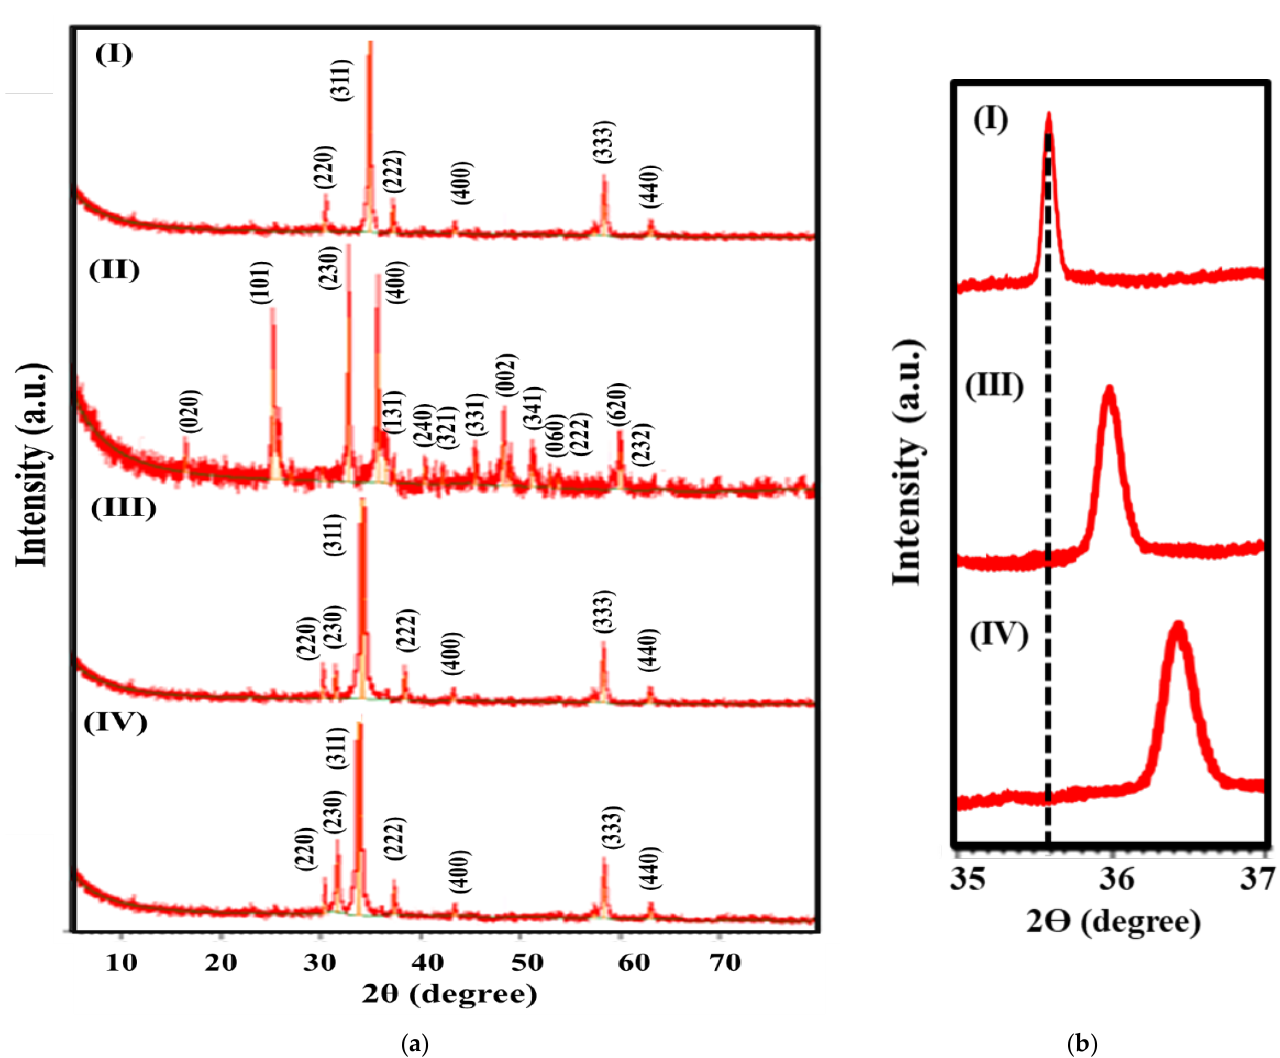
Figure 1. ( a ) XRD patterns, ( b ) enlarged view of peak shift position of the (311) Bragg peak of (I) SrFe 2 O 4 , (II) TiFe 2 O 5 , (III) Sr 0.7 Ti 0.3 Fe 2 O 4.3 and (IV) Sr 0.4 Ti 0.6 Fe 2 O 4.6 (Dotted black line represents the location of (311) Bragg peak for SrFe 2 O 4 Table 1. XRD parameters, ξ - potential and DLS hydrodynamic particle size of SrFe 2 O 4 , TiFe 2 O 5 ,